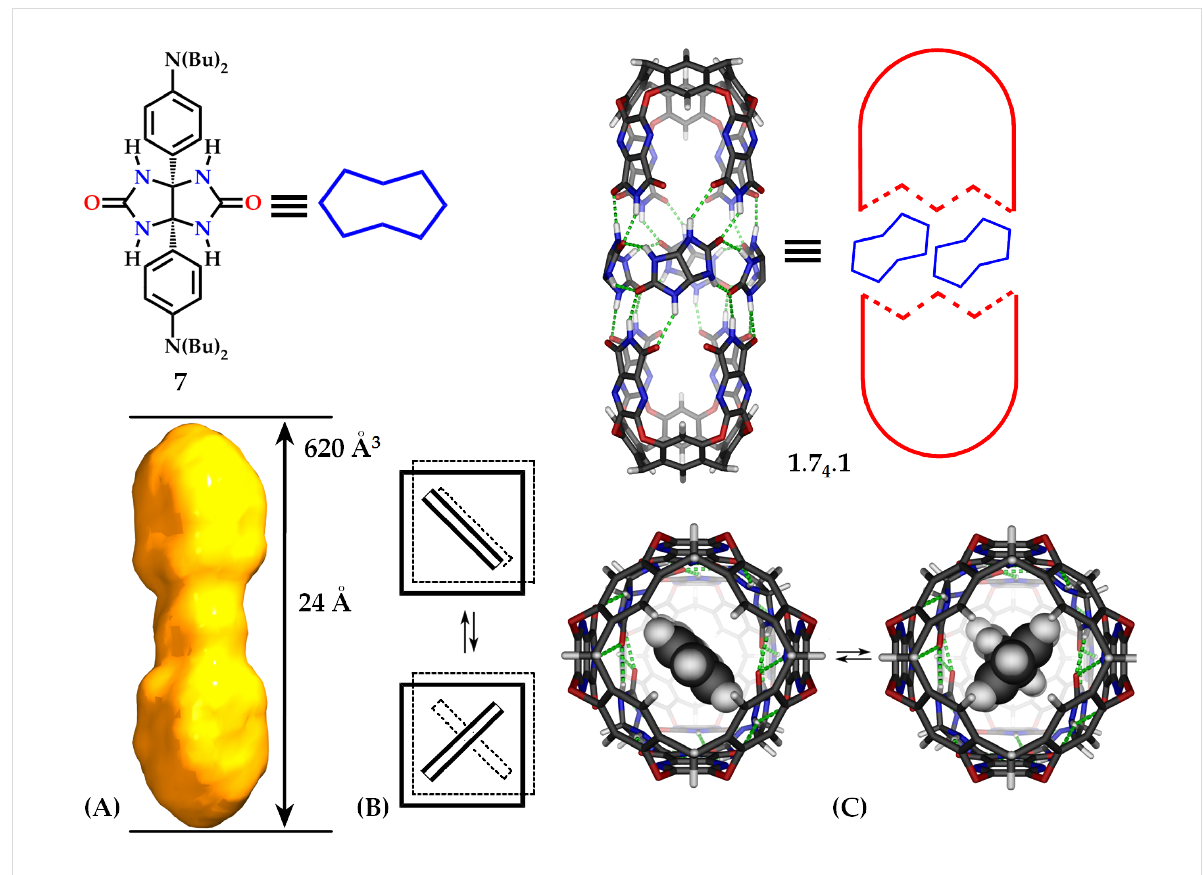
Figure 3: (Top) Glycouril 7 , the extended capsule 1.7 4 .1 , (only one enantiomeric arrangement is shown) and its cartoon representation. The shape of the space inside (A) a schematic view along the central axis with two aromatic guests (B) and an end-on view of an energy-minimized complex of stil- bene inside (C).